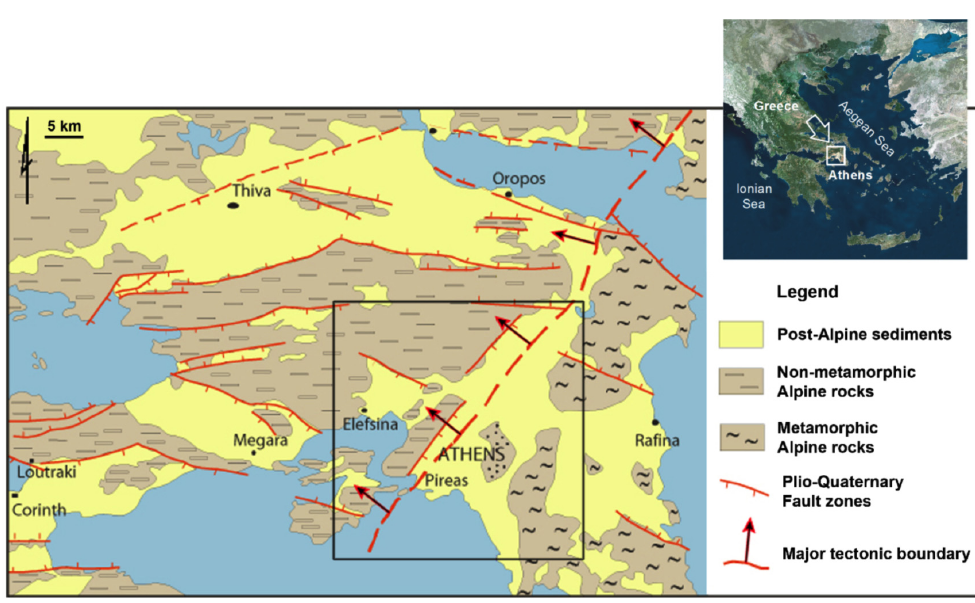
Figure 1. Simplified neotectonic map of Attica showing the approximate location of the major tectonic boundary, separating metamorphic and non-metamorphic alpine rocks (modified from Papanikolaou et al.